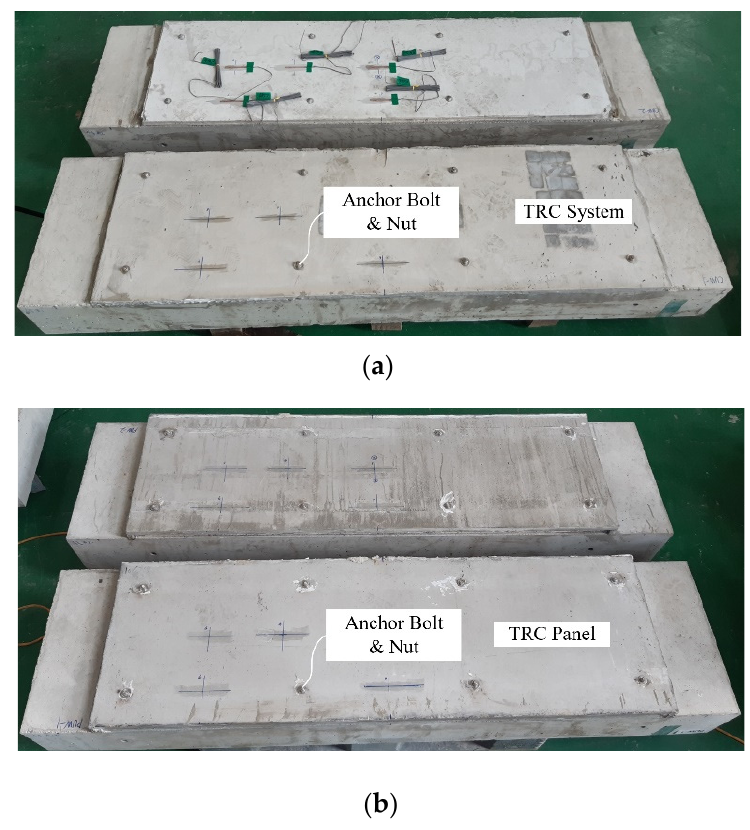
Figure 11. TRC system repaired RC specimens: ( a ) CUW series; ( b ) PUW series.